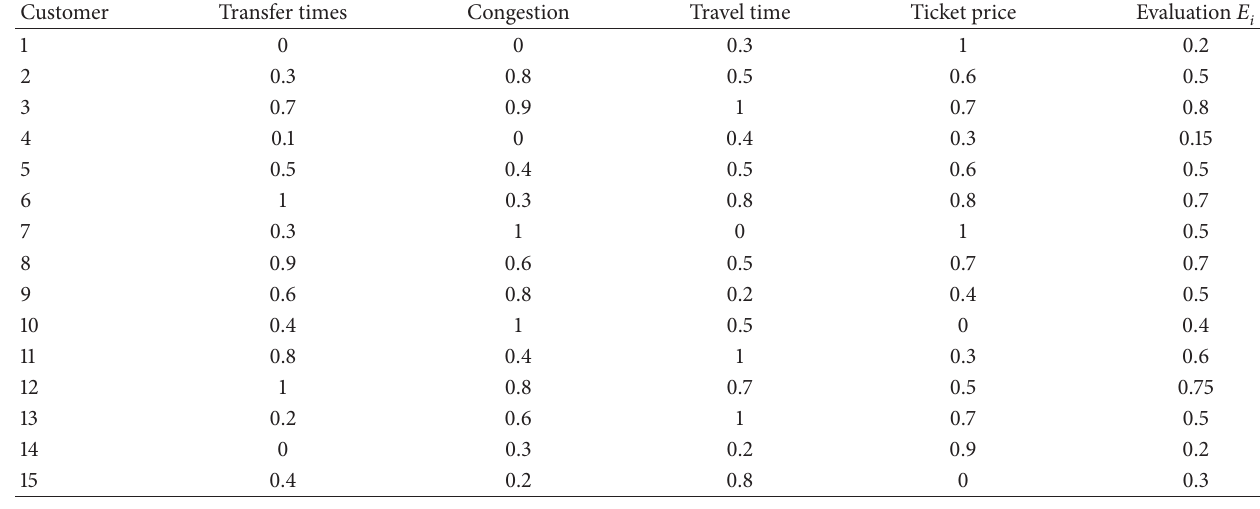
Table 5: Data of Example 17 (the customer evaluation).